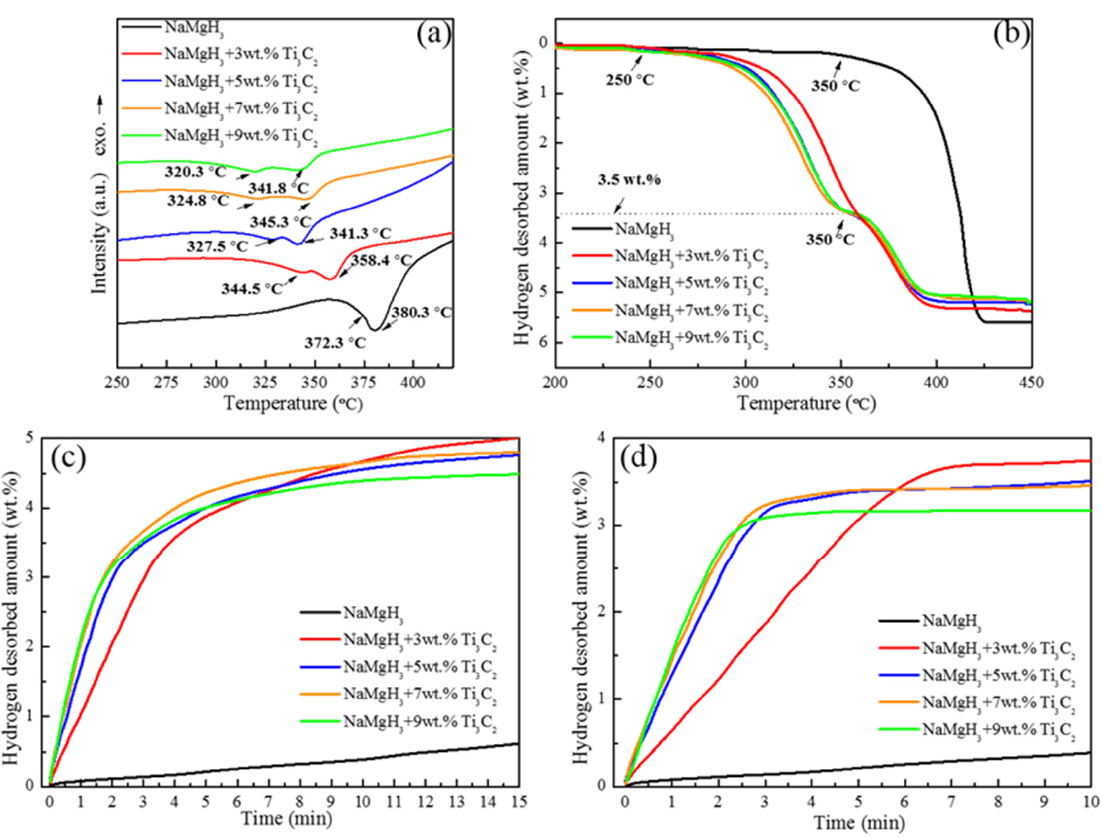
Figure 3. ( a ) DSC, ( b ) TPD, and isothermal dehydrogenation curves at ( c ) 365 °C and ( d ) 350 °C for NaMgH 3 -x wt.% Ti 3 C 2 (x = 0, 3, 5, 7, and 9) samples.